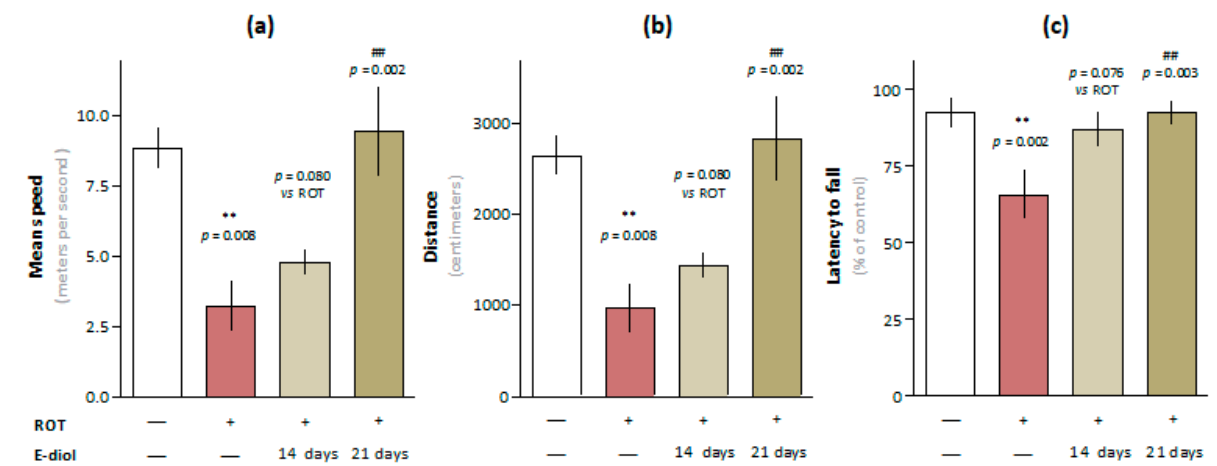
Figure 7. In vivo study of the motor function of C57BL/6J mice aged 3 months ( n = 10) in the Open Field test: average speed ( a ) and distance traveled ( b ). The data are presented as graphs in which each column represents the average value of an independent mice group (mean ± SEM). Evaluation of the E-diol e ff ect on motor coordination disorders of mice in the accelerating speed Rotarod test ( c ). The data are presented as latency to fall from rolling rod (mean ± SEM of time intervals from the beginning of the test to the fall of the animal from rolling rod for each experimental group). To assess the statistical signi fi cance, one-way ANOVA and Bonferroni’s multiple comparison tests were used, where ** p ≤ 0.01 versus control; ## p ≤ 0.01 versus ROT.